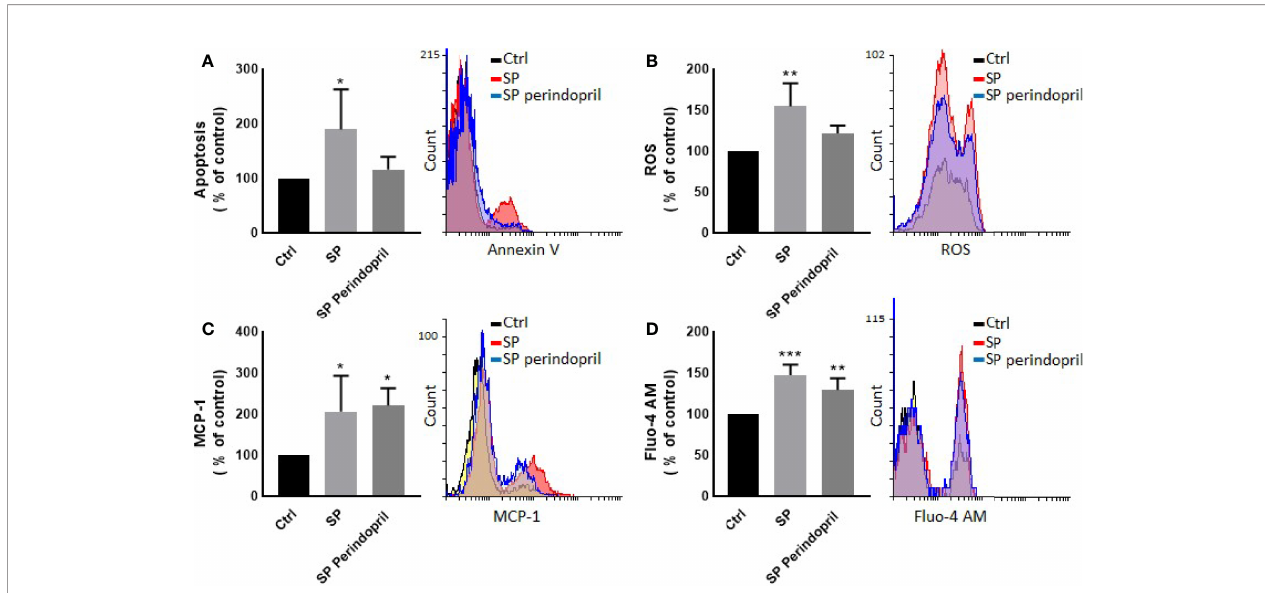
FIGURE 1 | Effects of spike (S) protein on cell viability and in fl ammatory markers. Thp-1 macrophages were mock treated (Ctrl), stimulated with S protein (SP) (100 nM) or SP with ACE inhibitor (SP Perindopril, 100 µM), perindopril, added 2 h before SP. (A) Apoptosis was measured by Annexin V binding essay. (B) Oxidative stress was evaluated by reactive oxygen species (ROS) expression. (C) Monocyte chemoattractant protein-1 (MCP-1) expression essay. (D) Fluo4 fl uorescence as a function of cytosolic free Ca 2+ intracellular calcium was performed using fl ow cytometry analysis. The data are presented as mean ± SEM, n = 4 – 5. Ordinary one-way ANOVA followed by Dunnett ’ s test: * p < 0.05, ** p < 0.01,*** p <